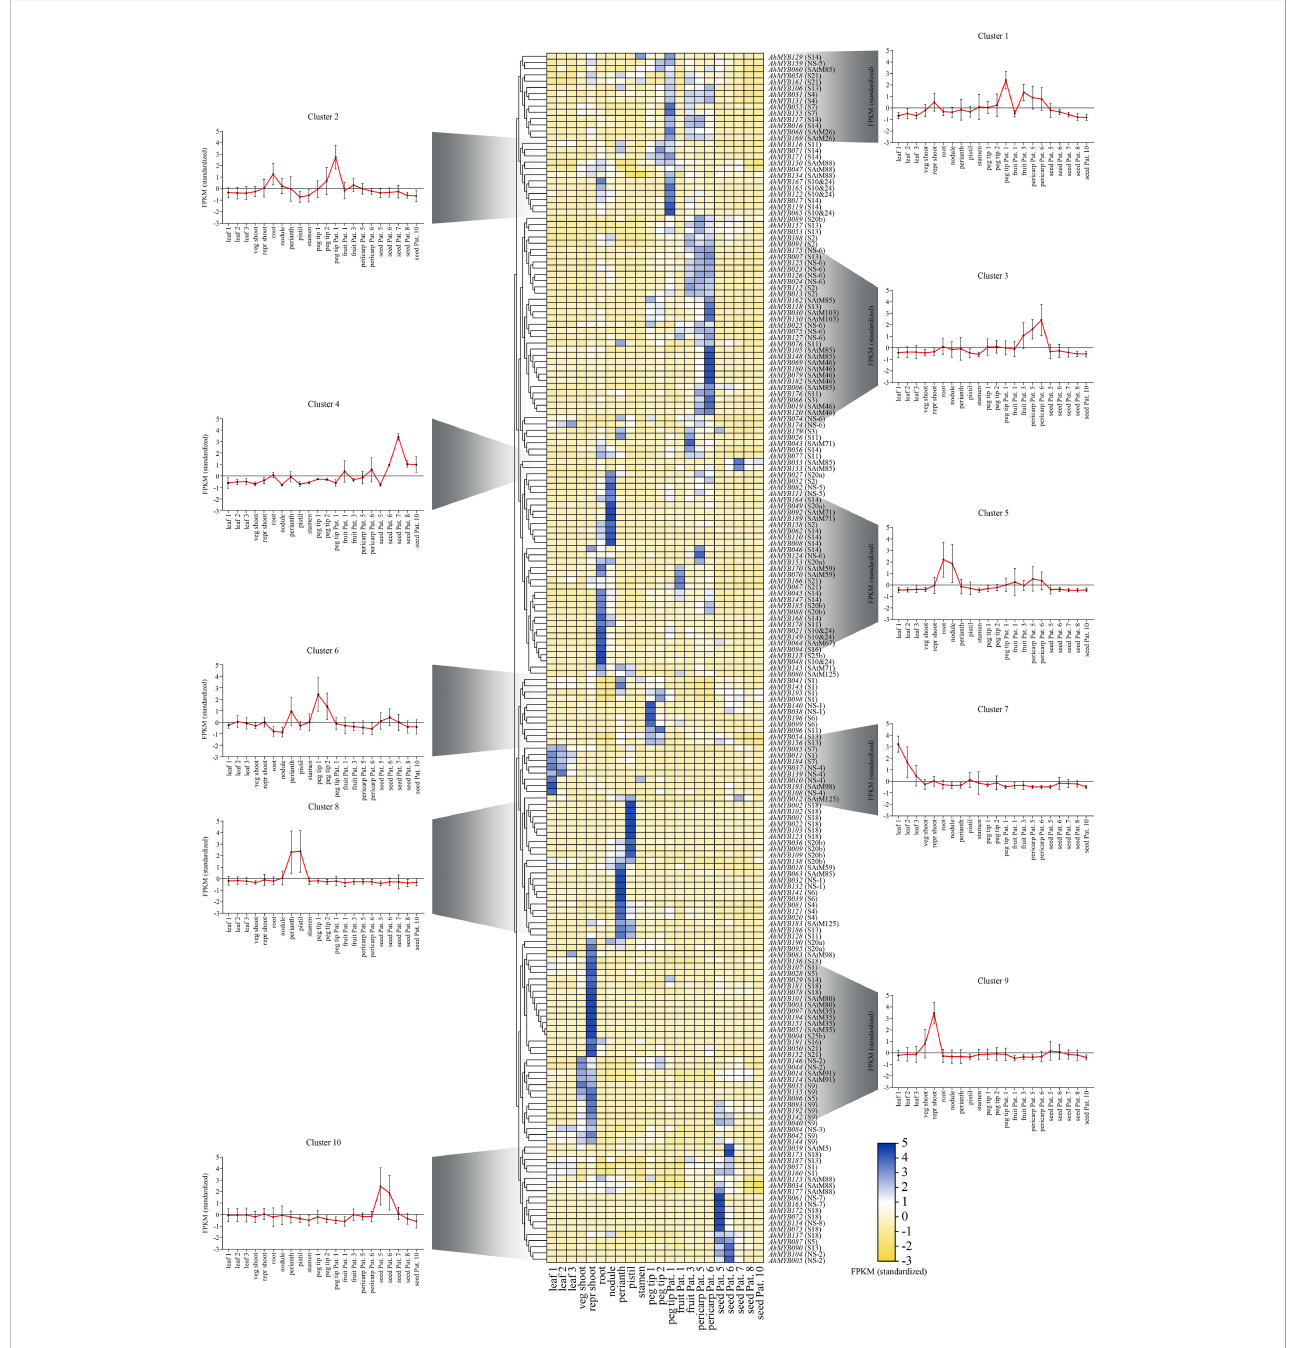
FIGURE 5 Heat map of the RNAseq transcript abundance pattern of the 194 R2R3-MYB genes in 22 different tissues in 10 expression clusters. For each gene, its name and the subgroup it belongs to were displayed on the right side of the heatmap. The expression pattern was generated based on the fragments per kilobase of exon per million fragments (FPKM) and analyzed by heatmap hierarchical clustering. The color scale (representing − 2 to 5) was shown. The meanings of the abbreviations of the 22 tissues were as follows: seedling leaf 10 days post-emergence (leaf 1), main stem leaf (leaf 2), lateral stem leaf (leaf 3), vegetative shoot tip from the main stem (veg shoot), reproductive shoot tip from fi rst lateral (repr shoot), 10-day roots (root), 25-day nodules (nodule), perianth, stamen, pistil, aerial gynophore tip (peg tip 1), subterranean peg tip (peg tip 2), Pattee 1 stalk (peg tip Pat. 1), Pattee 1 pod (fruit Pat. 1), Pattee 3 pod (fruit Pat. 3), Pattee 5 pericarp (pericarp Pat. 5), Pattee 6 pericarp (pericarp Pat. 6), Pat - tee 5 seed (seed Pat. 5), Pattee 6 seed (seed Pat. 6), Pattee 7 seed (seed Pat. 7), Pattee 8 seed (seed Pat. 8), and Pattee 10 seed (seed Pat.